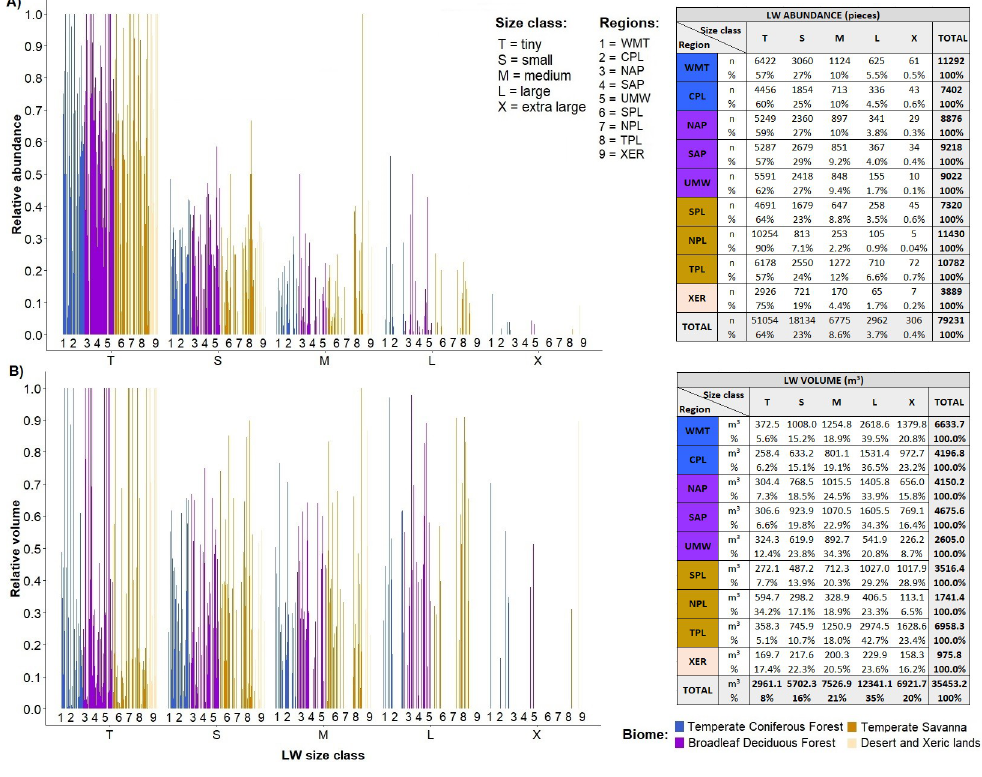
Fig 10. Diagrams of instream wood per size class in each site of USA regions. The relative abundance is showed in (A) and the relative volume in (B). Regions are indicated by letters and biomes by colours.